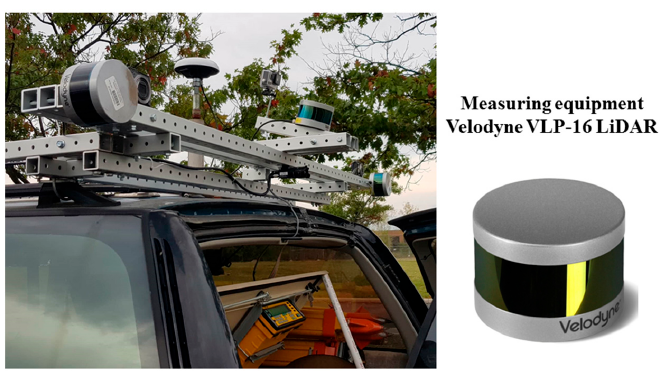
Figure 5. Rear view of the platform equipped with Velodyne VLP-16 LiDAR scanner.